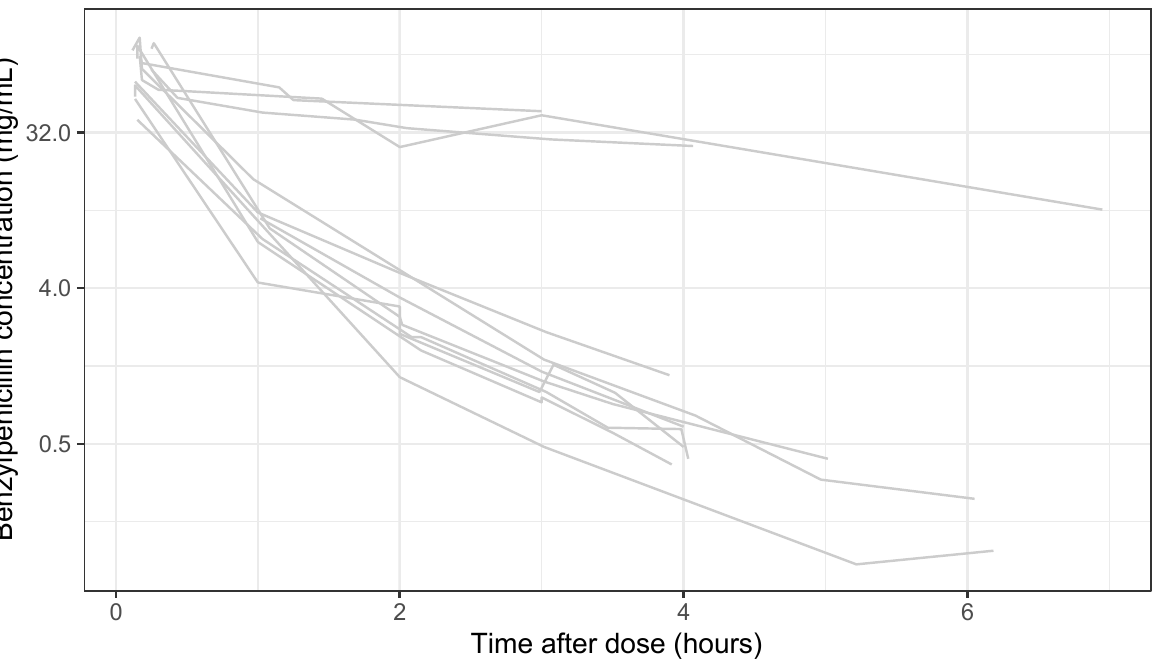
Table 2. Parameter estimates from final benzylpenicillin